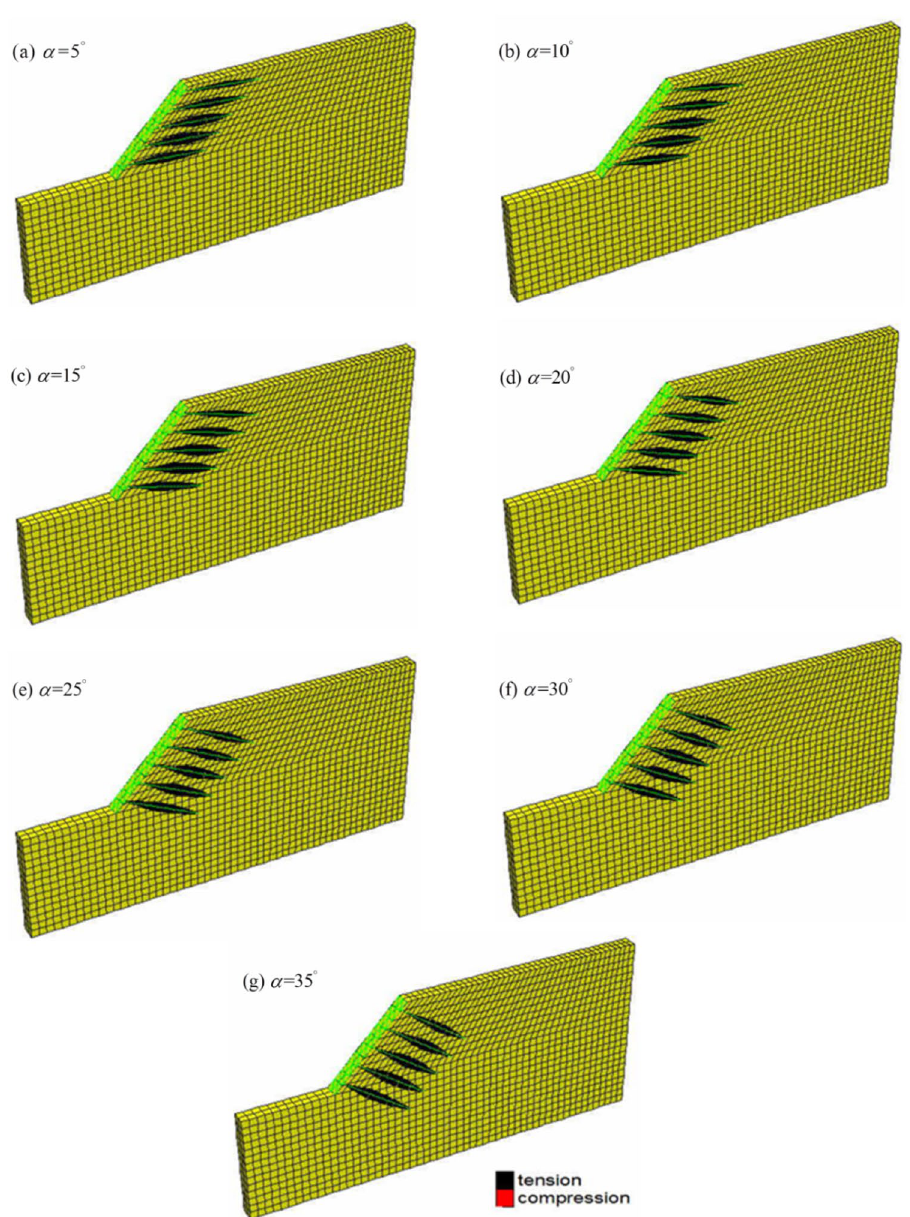
Fig. 6 The installation of the nail at different angles ( α = 5° to α = 35°) and the distribution of tension force across the nail for a specific angle of the excavation slope ( β =